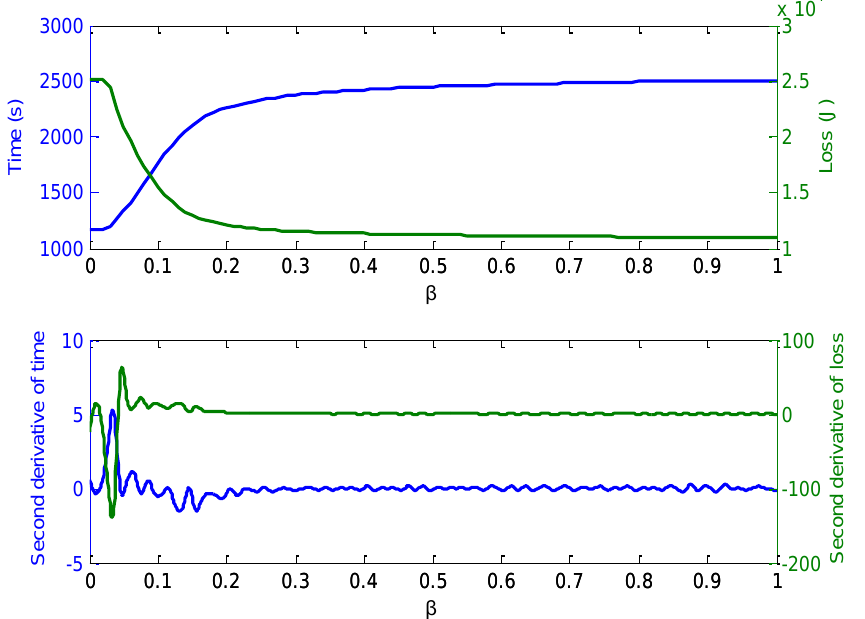
Figure 3. The time and loss change under different β.